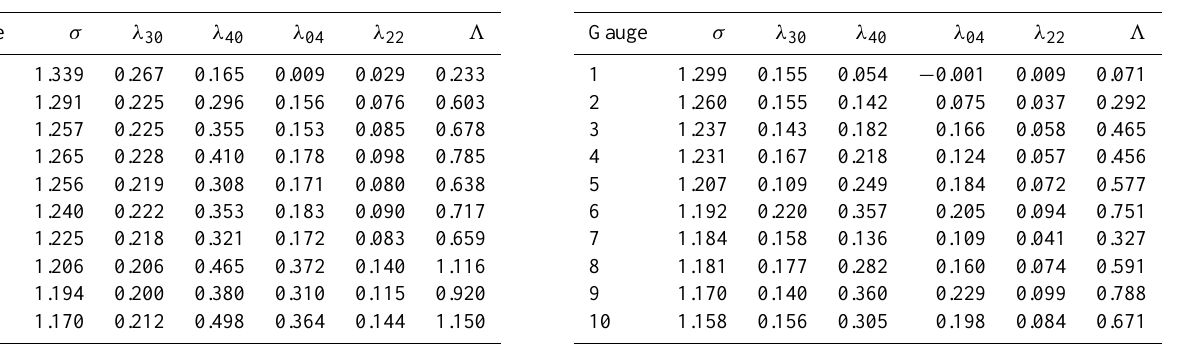
Table 3. Overall statistical averages from 15min segments for 8228: H s =4.6/2.3m, T p =7/14s.